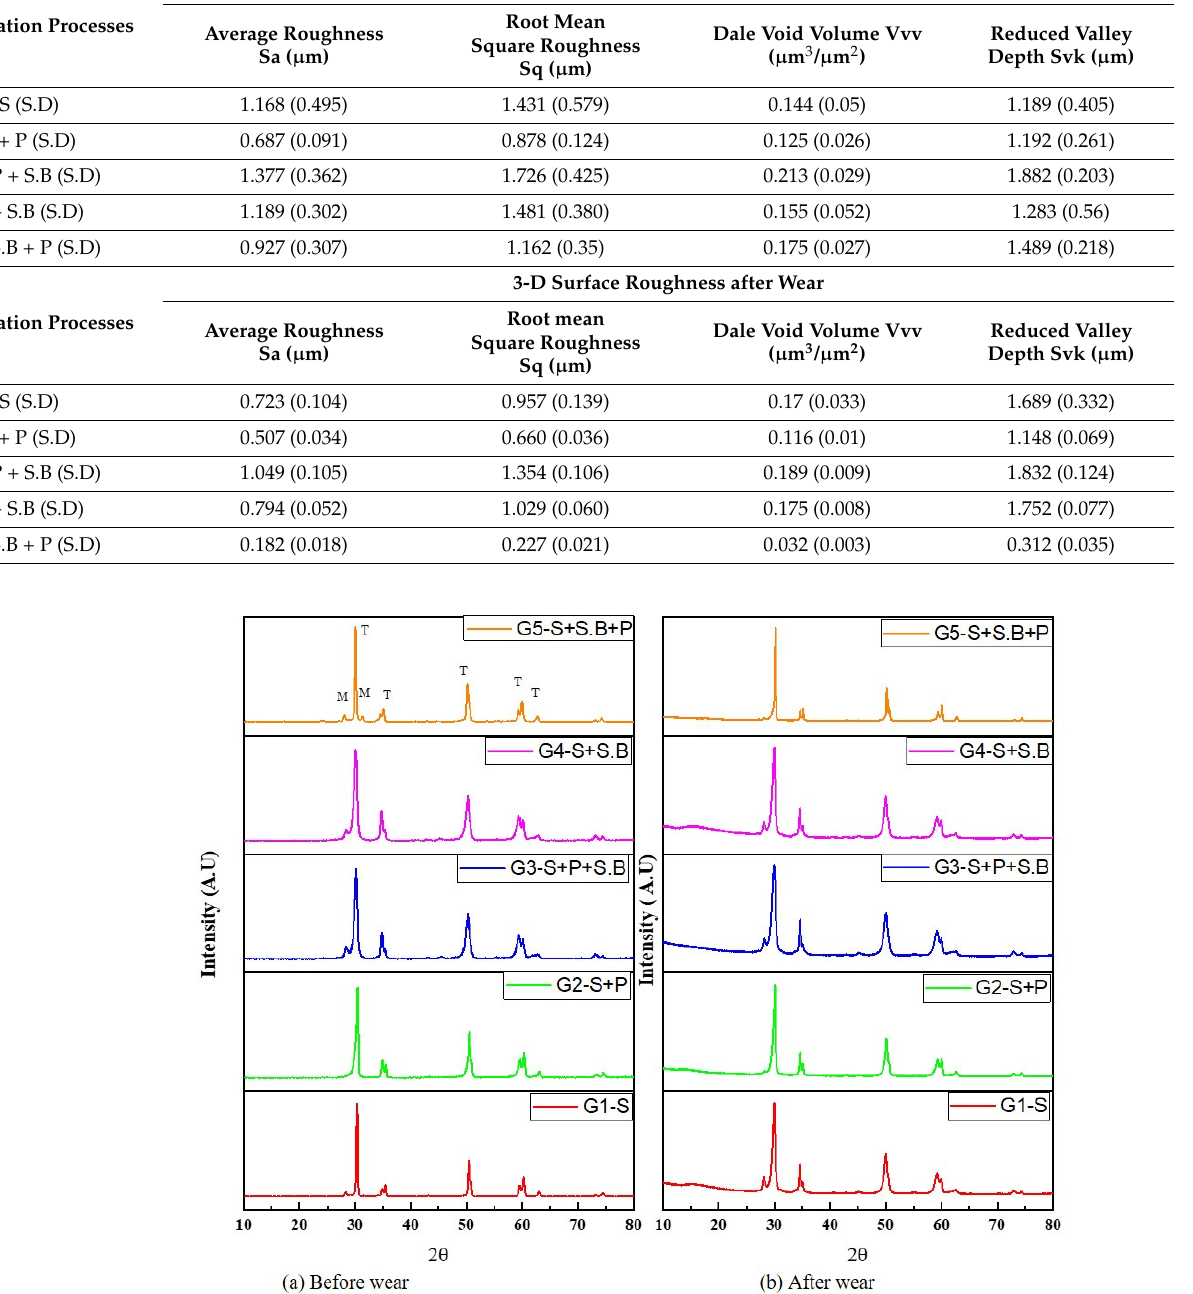
Figure 7. X-ray diffraction patterns of Y-TZP specimens ( a ) before and ( b ) after